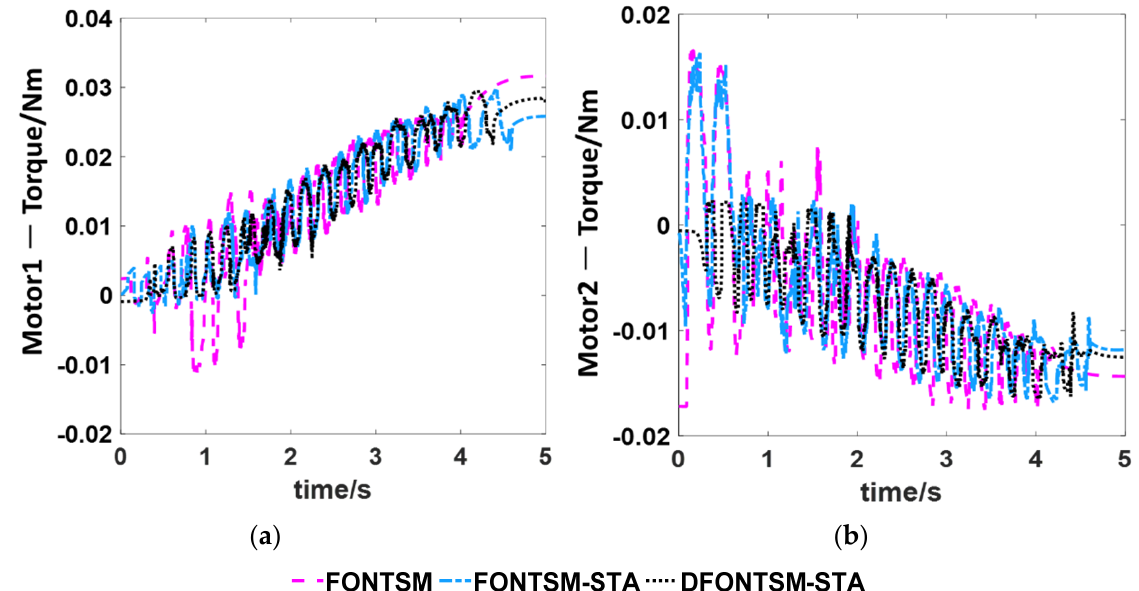
Figure 13. Input torques of the shoulder joints. ( a ): joint one; ( b ): joint two.